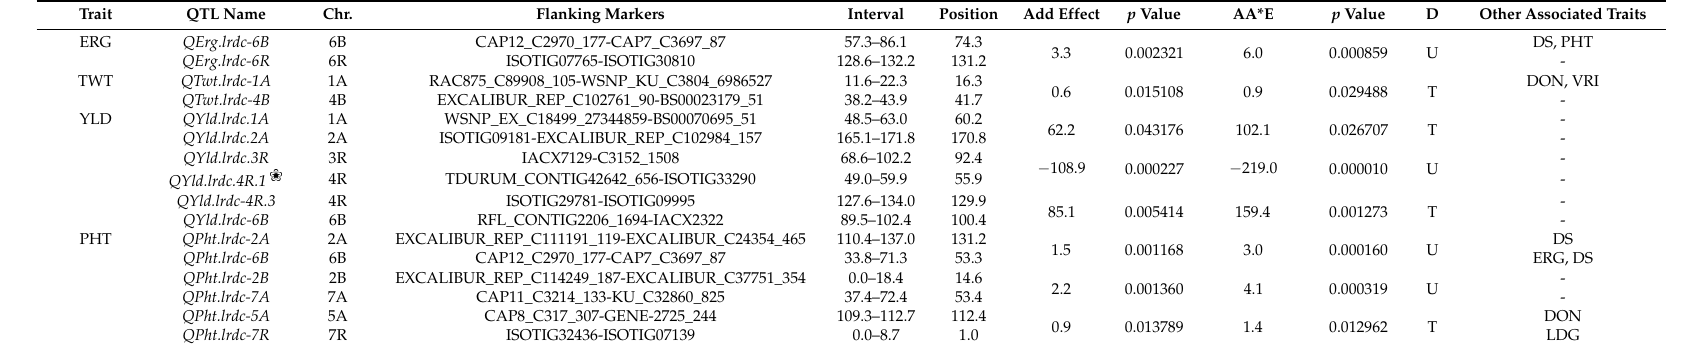
Table 7. Summary of epistasis QTL for ERG, PHT, TWT and YLD identified during the present